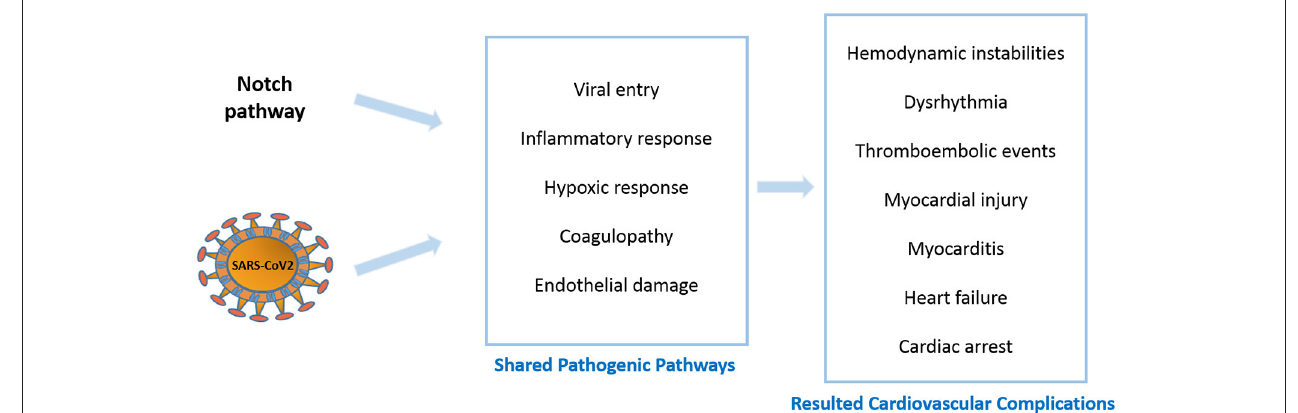
FIGURE 1 | Notch signaling and COVID-19 shared pathogenic events and resulted cardiovascular